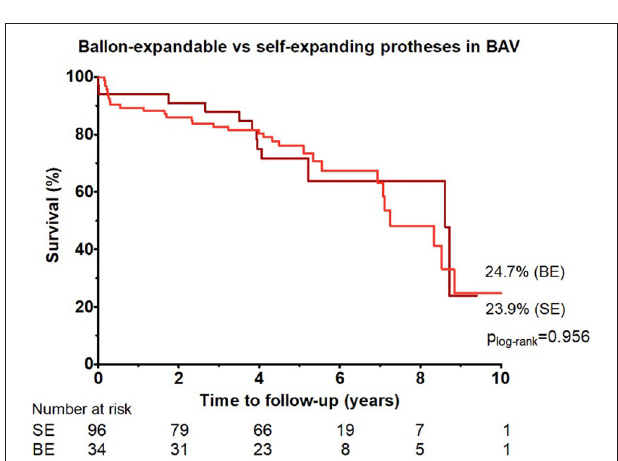
FIGURE 2 | Cumulative incidences of all-cause mortality among propensity-matched cohorts with bicuspid and tricuspid aortic valve up to 10 years of follow-up.